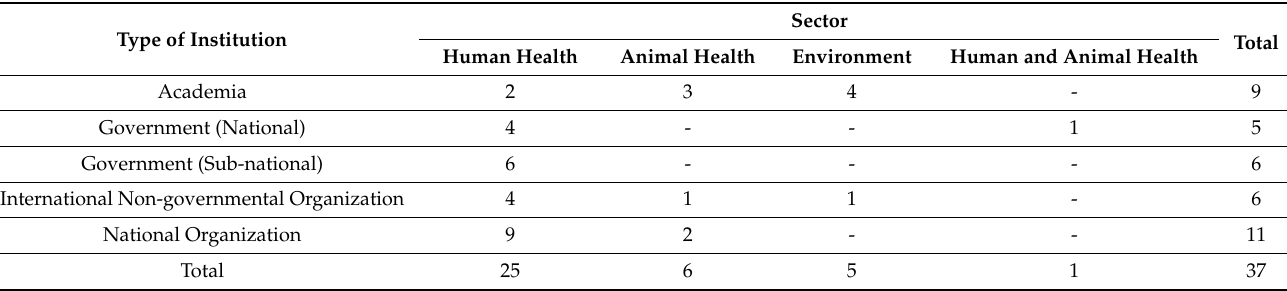
Table 1. Summary of respondents by type of institution and